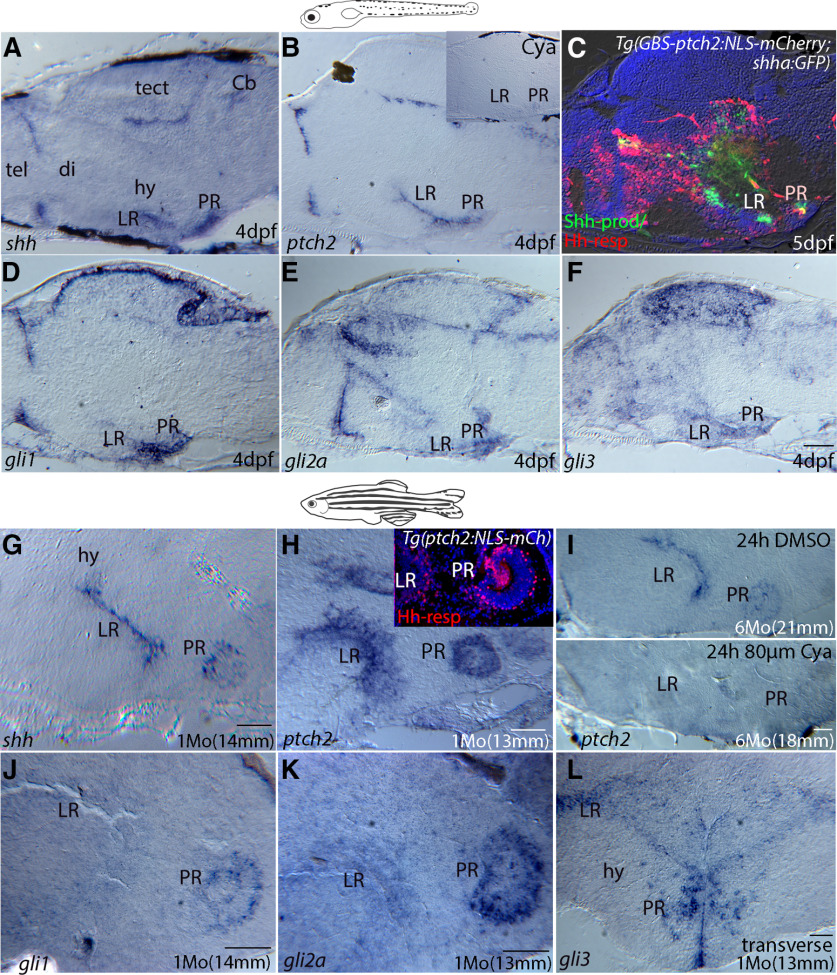
Hh pathway gene expression in the larval and adult zebrafish hypothalamus. A–F, Expression of Hh-signaling pathway genes in sectioned tissue from 4-dpf larvae. A, In situ hybridization (ISH) showing that shh is highly expressed in the ventricular regions of the LR and PR of the hypothalamic ventricle, as well as in ventricular regions of the diencephalon/telencephalon border, cerebellum, and tectum. B, The Hh-target gene patched2 is similarly expressed in ventricular regions throughout the larval brain, with ptch2 transcription being eliminated by treatment with Cya (B, inset). C, Shh-producing (green, Shh-prod) and ptch2 (red, Hh-resp) expression in the larval brain as revealed by the Tg(shha:GFP) and Tg(GBS-ptch2:NLS-mCherry) reporter lines, seen here in a double transgenic larva. This midline section reveals Hh response in the midline ventricular region. D–F, ISH showing expression of the Hh-responsive transcription factors gli1, gli2a, and gli3, respectively. G–L, ISH on tissue sections showing expression of Hh signaling pathway genes in the adult hypothalamus. G, shh expression is maintained in the LR and PR of the adult hypothalamic ventricle. H, Expression of the Hh-target gene patched2 in the hypothalamic ventricular regions as revealed by ISH and compared with nuclear mCherry expression in cells of the LR and PR driven by the ptch2 promoter construct in the Tg(GBS-ptch2:NLS-mCherry) transgenic line (inset). I, ISH using a ptch2 probe shows that Cya treatment (bottom panel) of six-month-old adult dramatically reduced ptch2 gene expression in the LR and PR compared with an age-matched DMSO control treated fish (top panel). J–L, ISH showing expression of the Hh-responsive transcription factors gli1, gli2a, and gli3, respectively, in the hypothalamus. All panels show sagittal tissue sections, except L, which shows a transverse tissue section. cb, cerebellum; di, diencephalon; hy, hypothalamus; tect, tectum; tel, telencephalon. Scale bars: 50 μm.